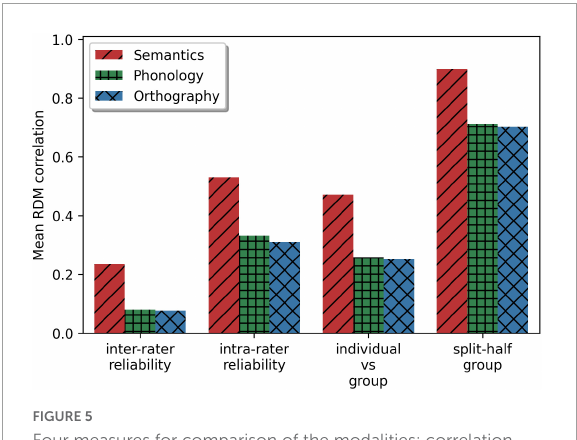
FIGURE5 Four measures for comparison of the modalities: correlation between participants, within participants, between participants and group level, and split-half reliability of the group-level